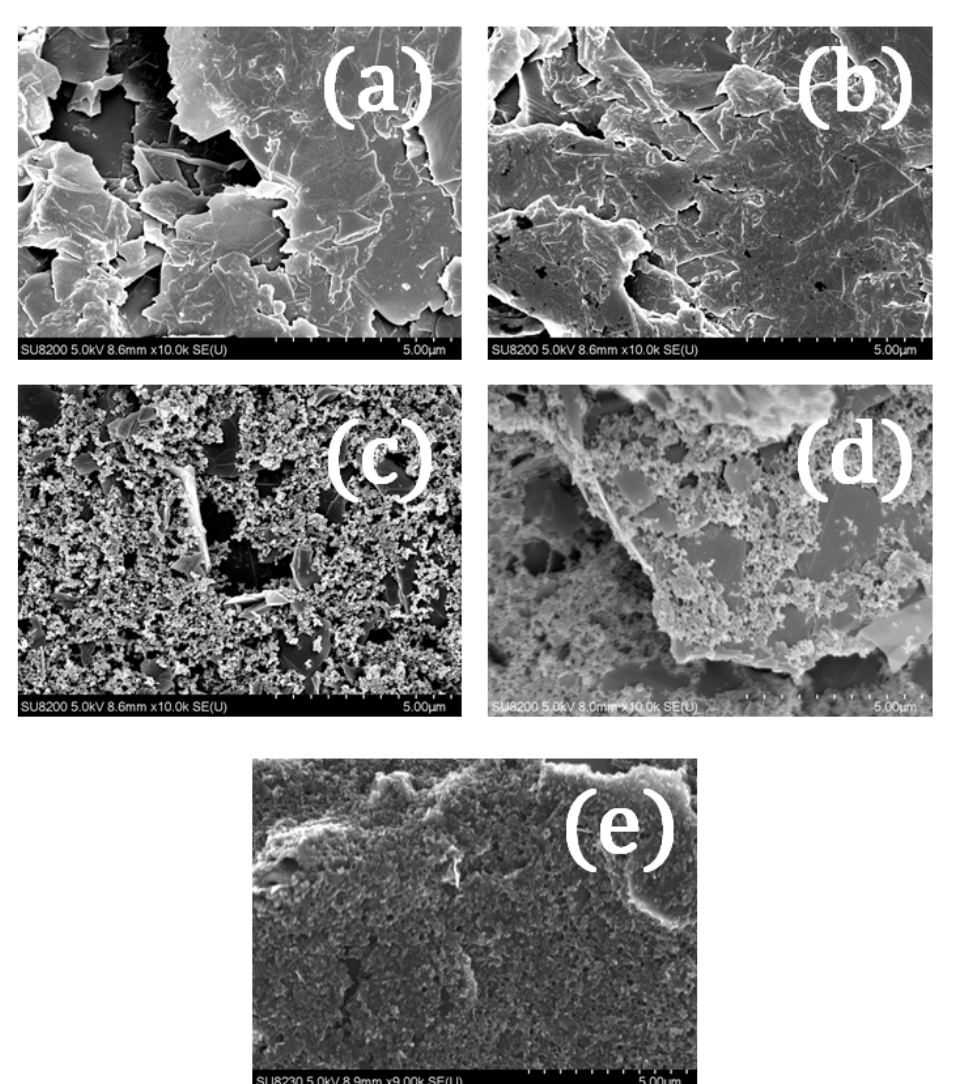
Figure 5. SEM images of SPEs carbon layer; ( a , b ) GNP-1 and GNP-2 layers, respectively, with clearly visible GNPs’ surfaces that are covered by a bulging polymer layer; ( c ) GNP-3 with visible addition of CB to the layer but covering the GNP’s surface; ( d ) GNP-4, covered by a polymer matrix to a much less extent; instead, carbon black particles are visible covering the GNPs. ( e ) PF-407 being covered by the polymer (probably less viscous than in experimental pastes GNP-1 through -4).